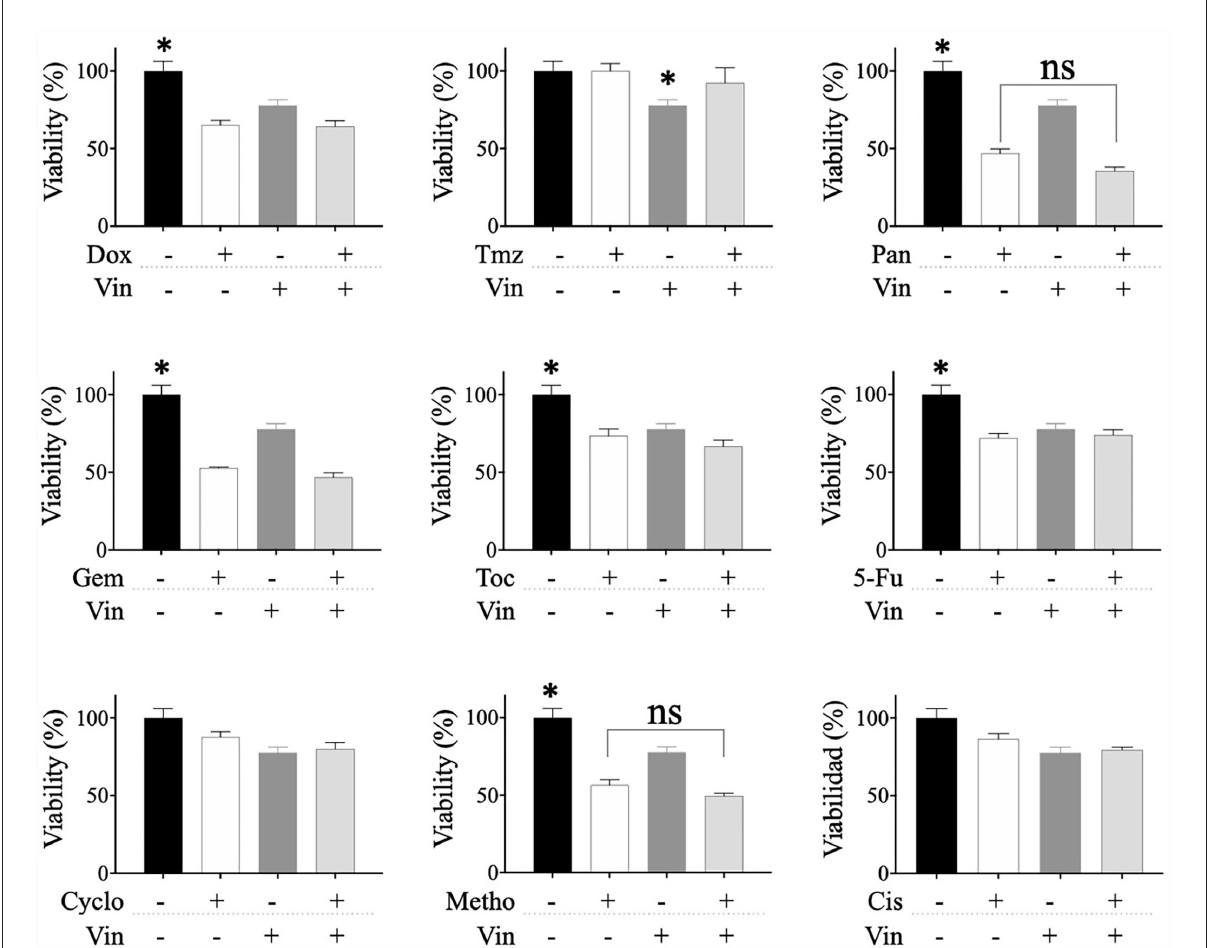
FIGURE5 Viability of CTVT cells exposed to the sequential administration of different drugs plus vincristine. CTVT cells (5 × 10 3 /well) were exposed to the CC 50 of the drugs Dox, Tmz, Pan, Gem, Toc, 5-Fu, Cyclo, Metho, or Cis for 24h. Then each drug was withdrawn, and a 1:1 dilution of the CC 50 of Vin was added for 24h. The relative cell viability was determined with the Alamar Blue assay. Each bar graph represents the average of 3 independent experiments ± SD. Statistical significance was determined using Tukey’s post hoc test (* p < 0.05), no significance (ns). Vin, vincristine; Dox, doxorubicin; Tmz, temozolomide; Pan, panobinostat; Gem, gemcitabine; Toc, toceranib; 5-Fu, 5-fluorouracil; Cyclo, cyclophosphamide; Metho, methotrexate; Cis,